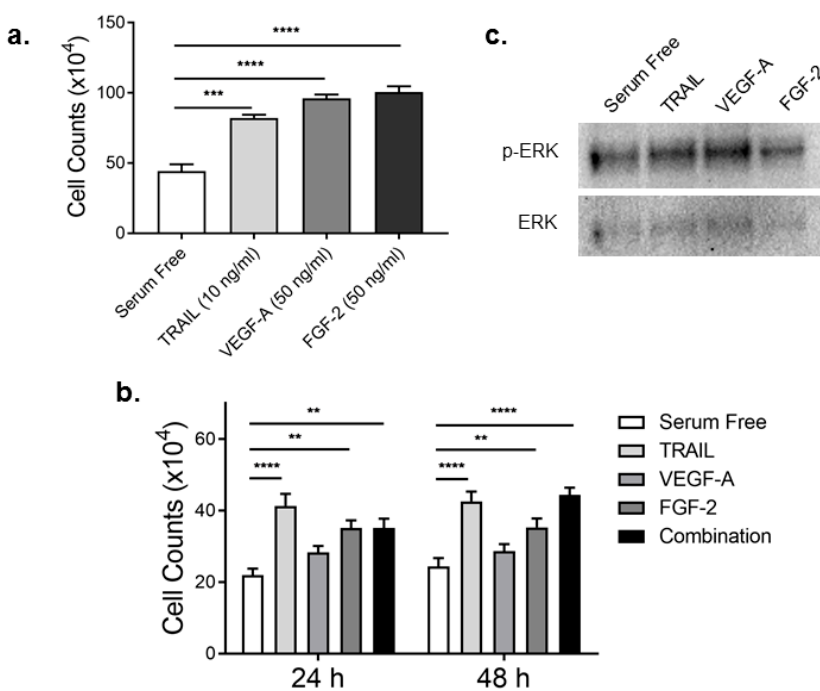
Figure 1. TRAIL and FGF-2 promote HMEC-1 cell proliferation. ( a ) Serum-starved HMEC-1 were exposed to TRAIL, VEGF-A and FGF-2 using indicated concentrations known to promote proliferation. Total cell counts were assessed 24 h later ( n = 3/condition); ( b ) Serum-arrested HMEC-1 treated with TRAIL (10 ng/mL), VEGF-A (10 ng/mL), FGF-2 (10 ng/mL) or a combination of all three (each at 10 ng/mL). Cells were then assessed for total cell counts at 24 and 48 h ( n = 3/condition); ( c ) ERK phosphorylation and expression. Serum-starved HMEC-1 were treated with each growth factor (10 ng/mL) for 15 min, followed by total protein extraction and Western blotting. Results are expressed as the mean ± SEM; ANOVA; ** p < 0.01, *** p < 0.001, **** p < 0.0001.